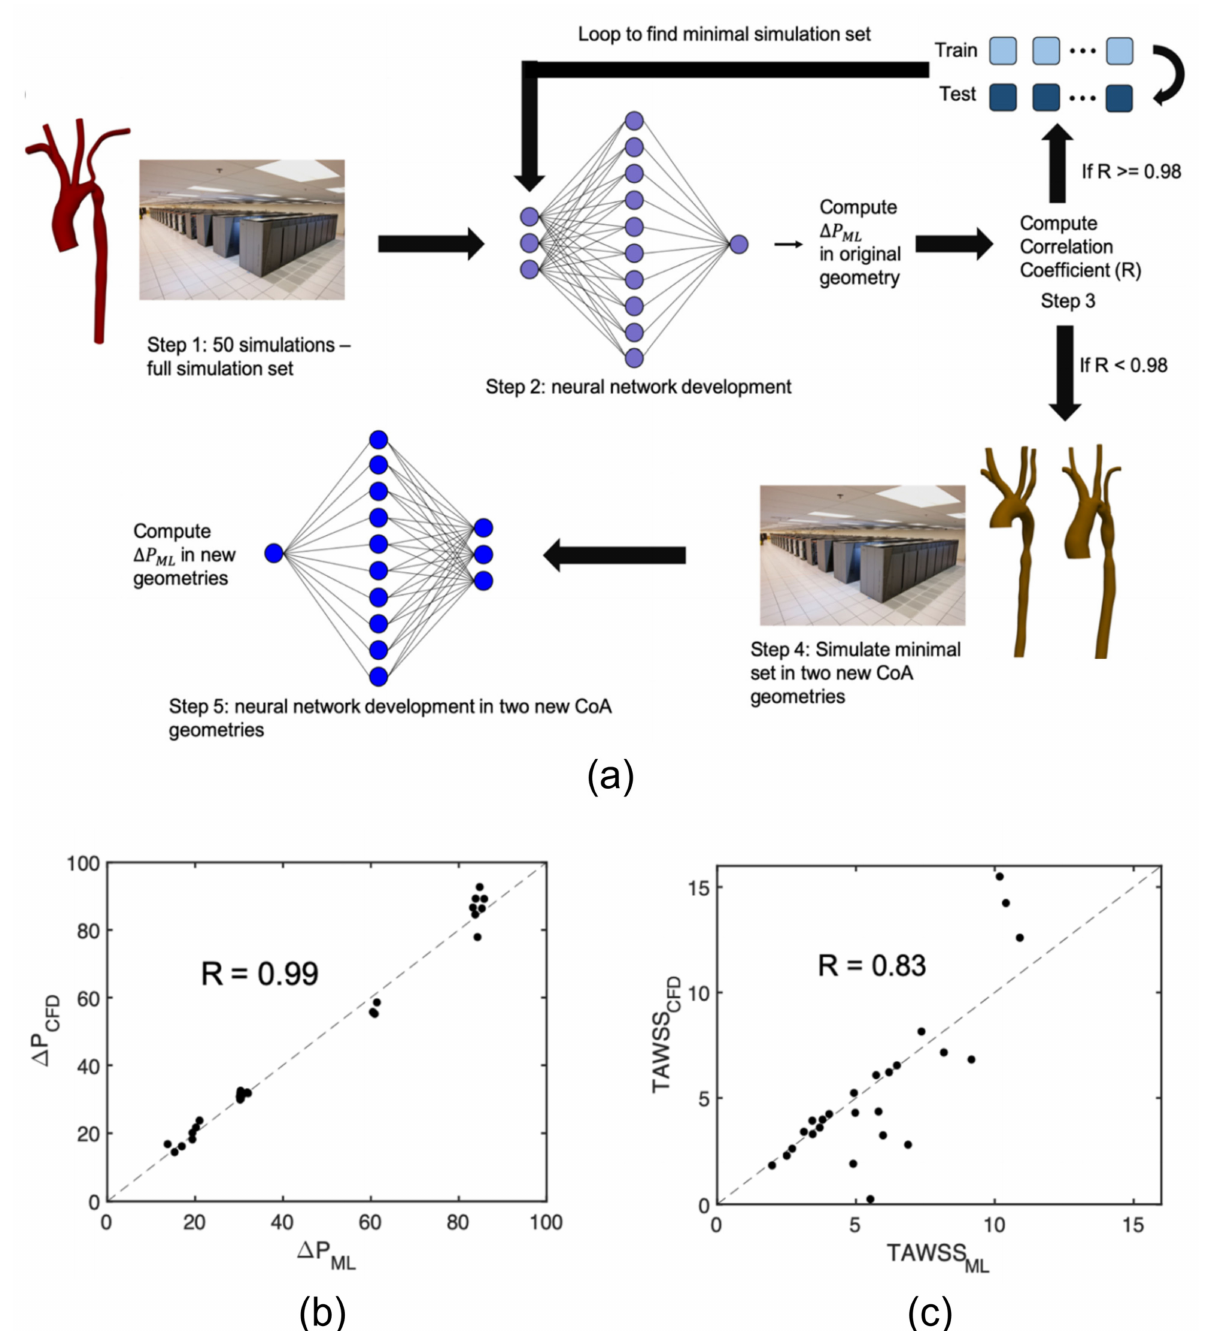
Figure 5. Case study for machine learning framework for surrogate modeling of pressure gradi- ent and WSS for patients with coarctation of the aorta [58] ( a ) Design of experiments workflow. ( b ) ML results comparing predicted and simulated pressure. ( c ) ML results comparing predicted and simulated